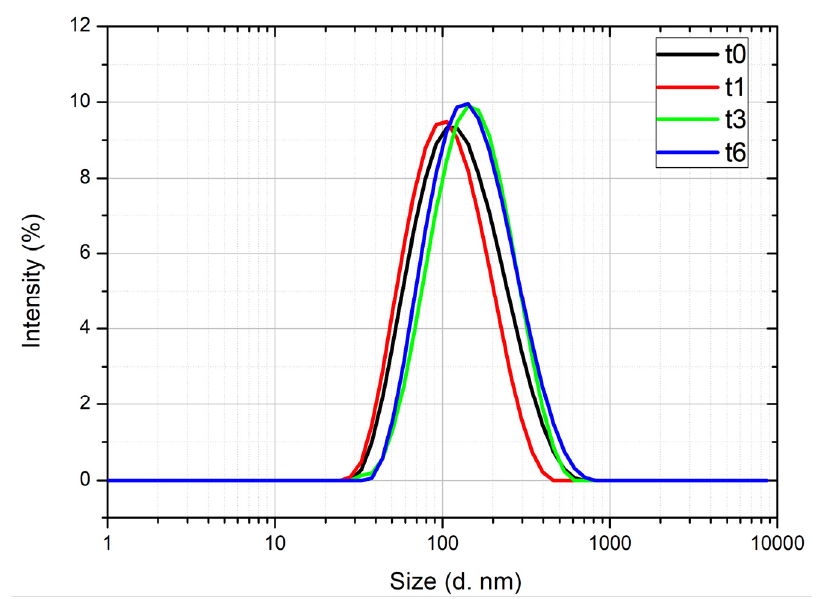
Figure 2. Dynamic light scattering (DLS) traces of Carlina acaulis essential oil-based nanoemulsion, at different time points: 0 day (t0), 1 month (t1), 3 months (t3), 6 months (t6).